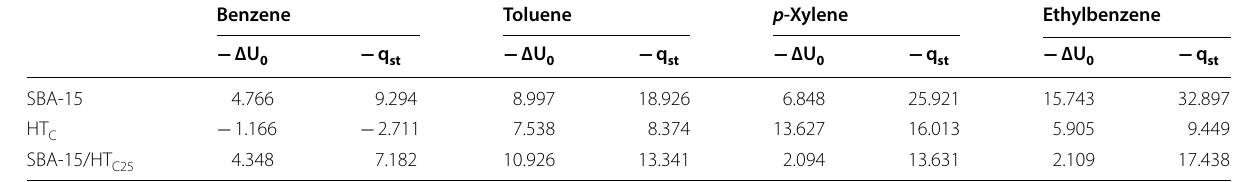
Table 6 Values of the free standard adsorption energy and the isosteric heats of